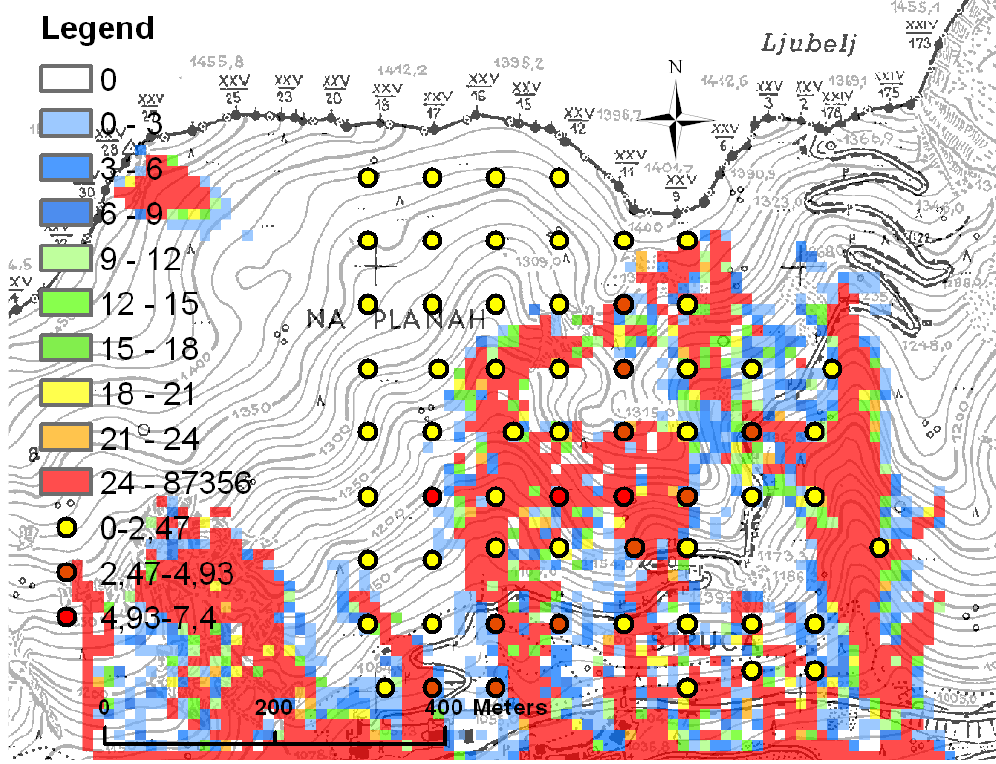
Figure 6. Number of deposited rocks and silent witnesses (number of retained stones per tree, labeled by coloured circles) for the current forest